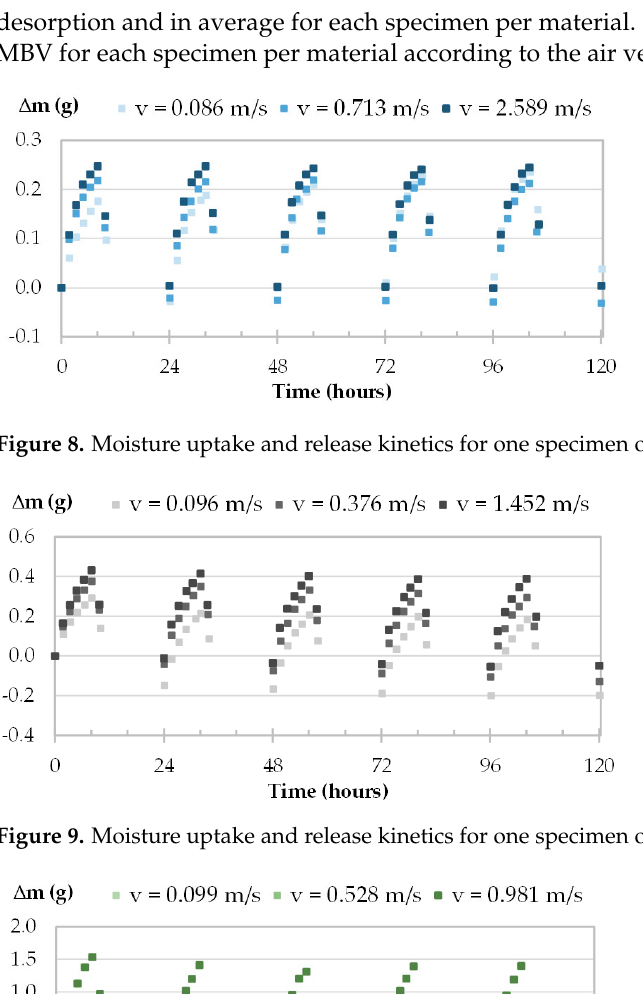
Figure 10. Moisture uptake and release kinetics for one specimen of TH (TH-c-7) in tests 1-2-3.